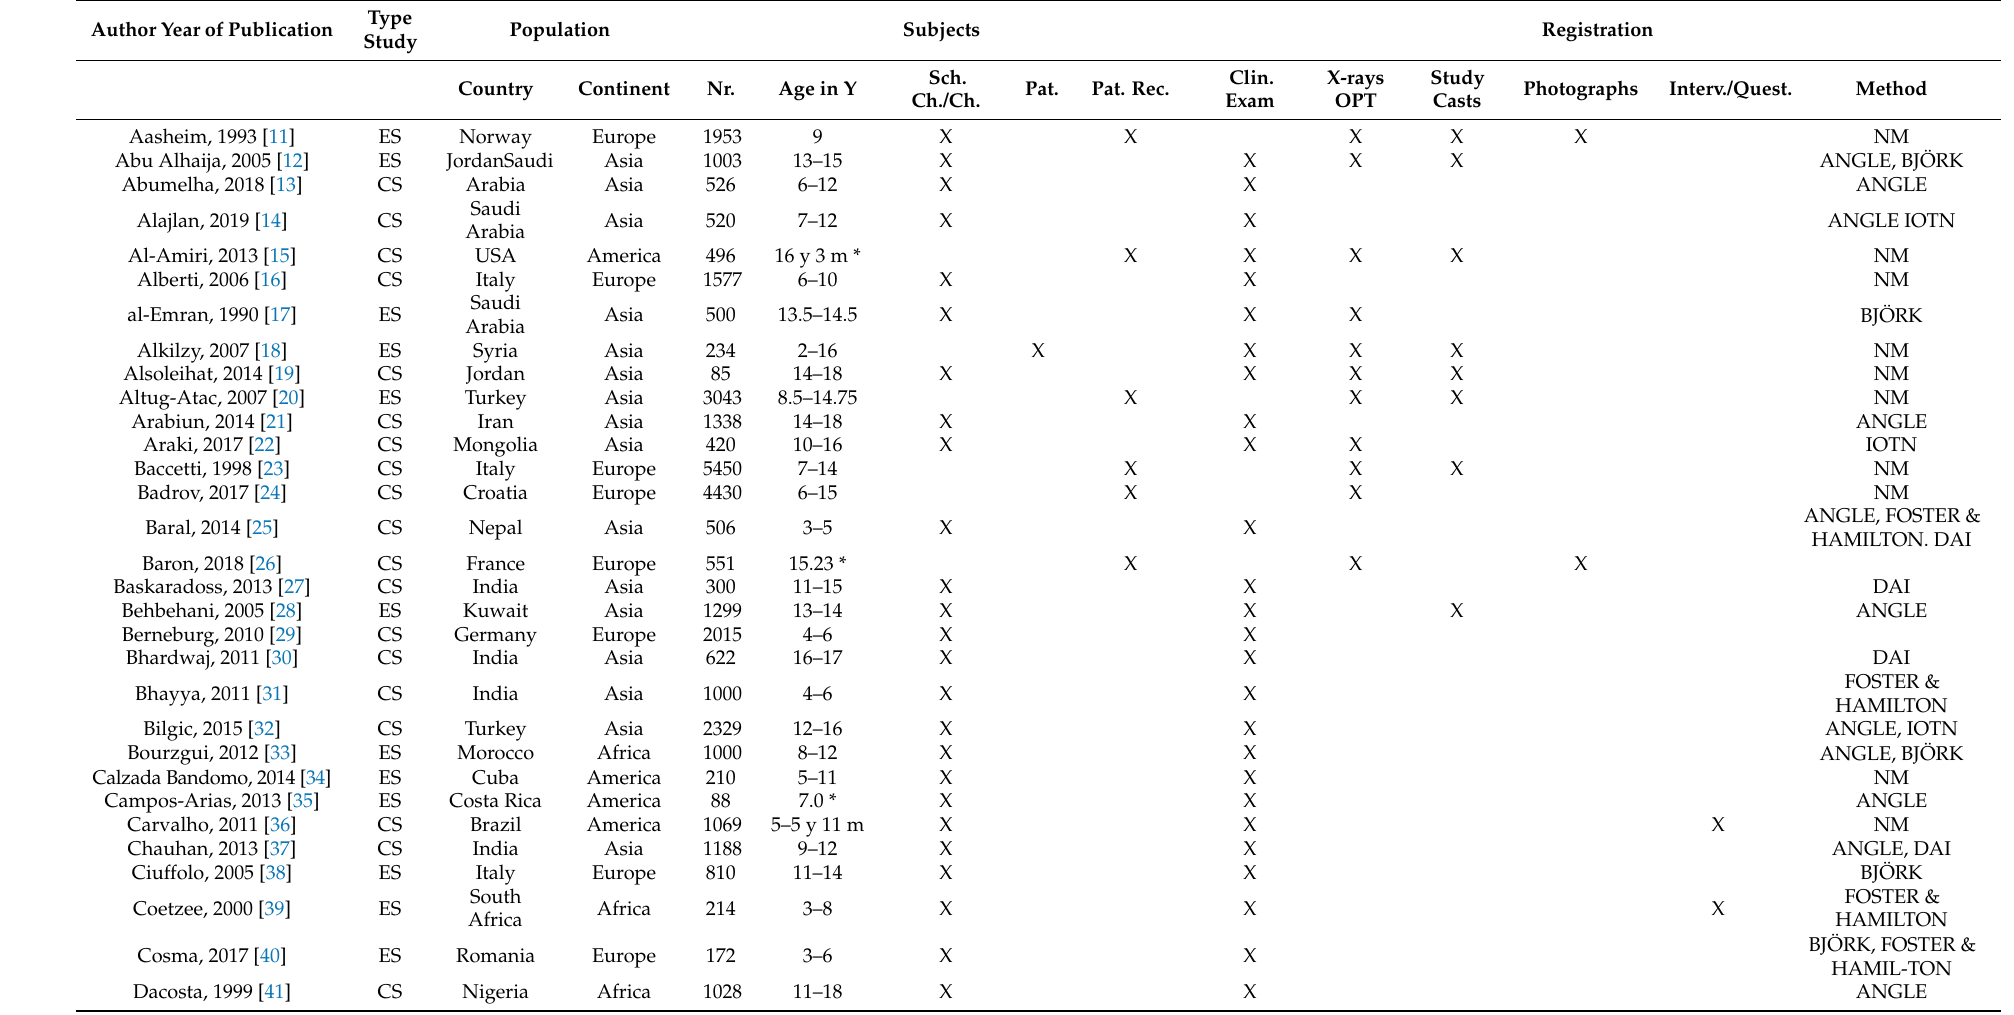
Table 1. Characteristics of and methods used in the included